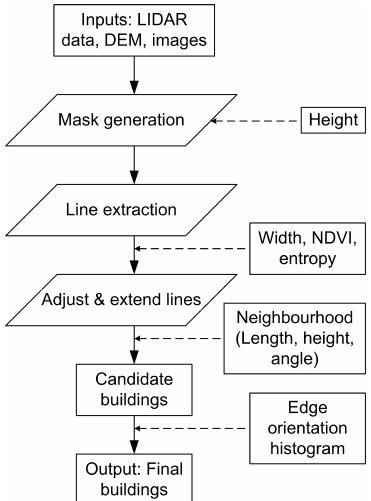
Figure 1: Flow diagram of the improved building detection tech- nique.